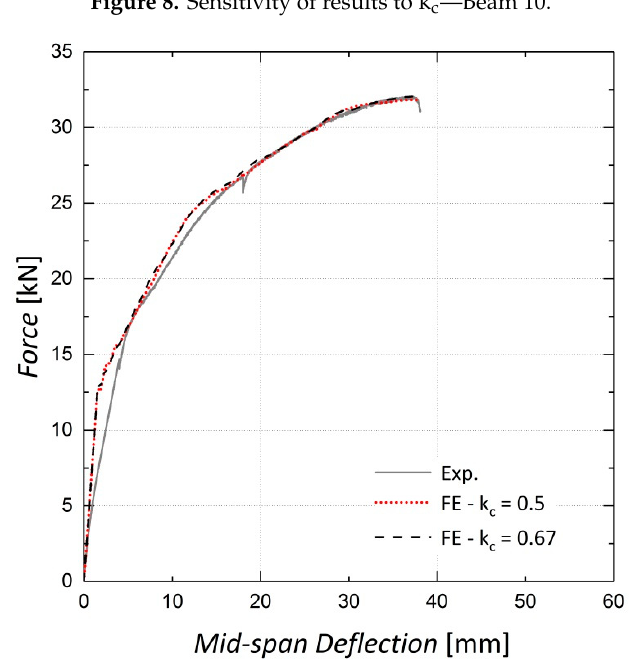
Figure 8. Sensitivity of results to k c —Beam 10.